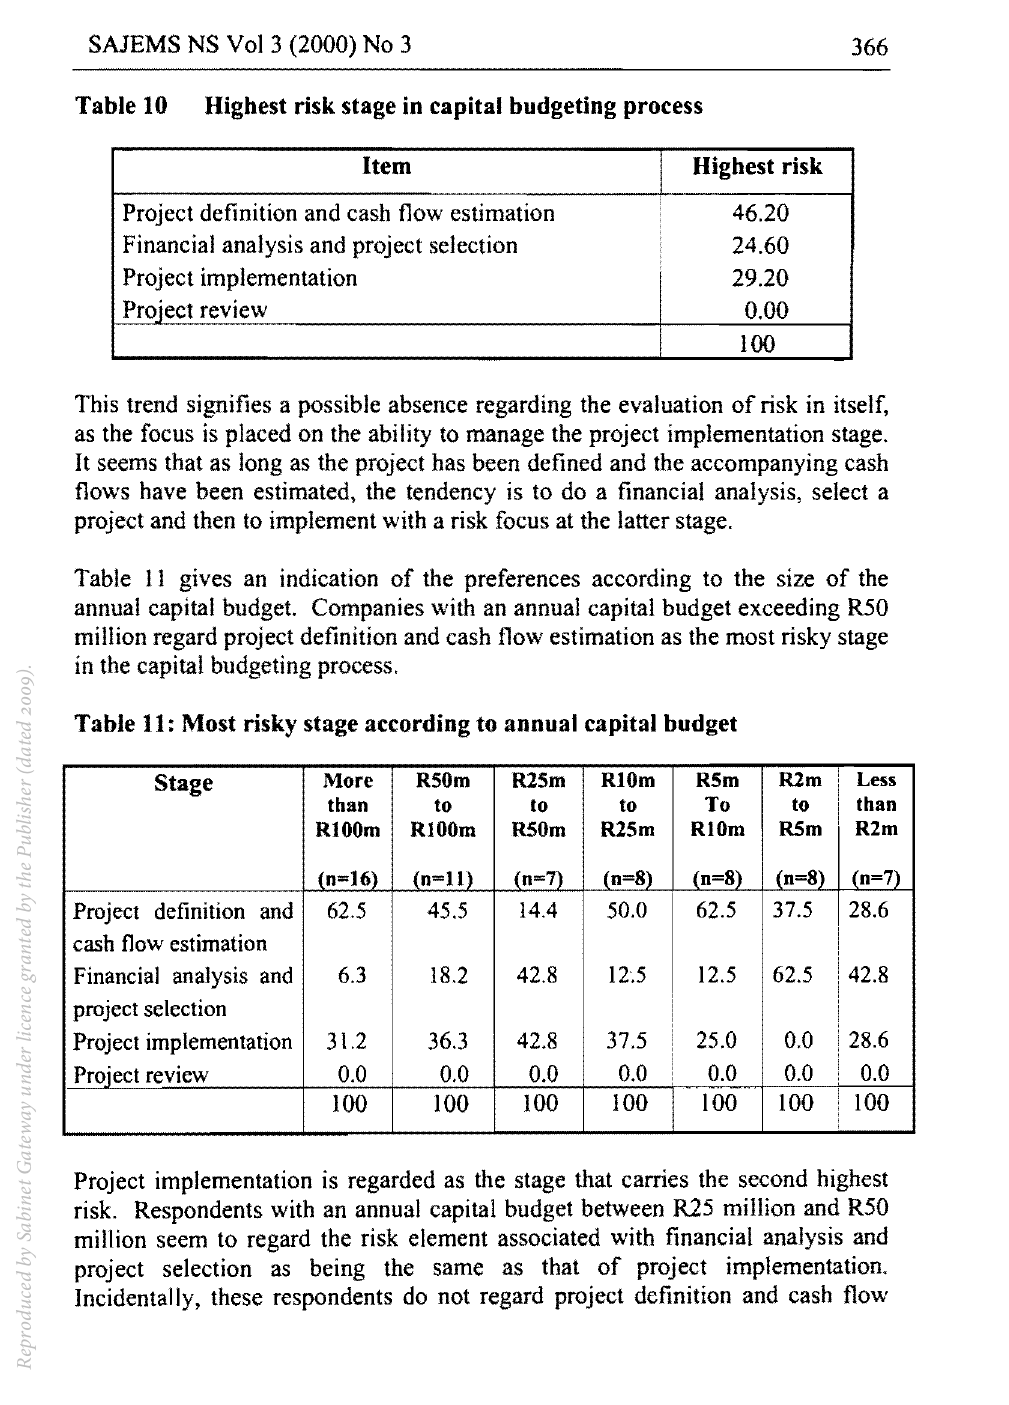
Table 11: Most risky stage according to annual capital budget